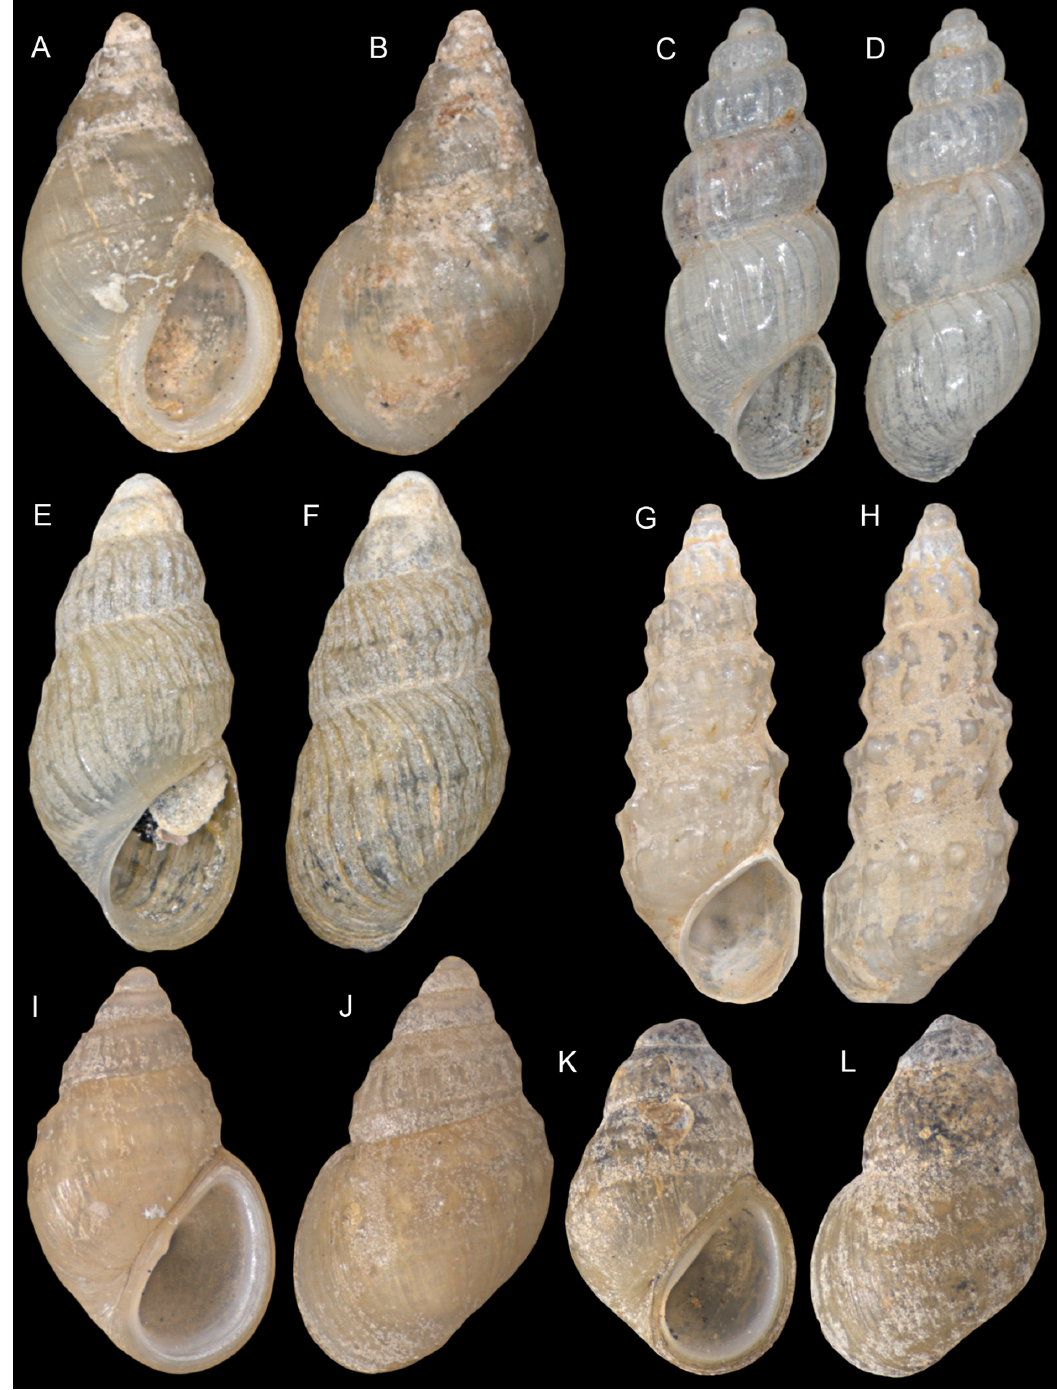
Fig. 3. A–B . Hydrorissoia cambodiensis Brandt, 1970, probable paratype MZSP 95912, L = 3.9 mm, W = 2.3 mm. C–D . Hubendickia cylindrica Brandt, 1974, probable paratype MZSP 95944, L = 4.5 mm, W = 1.8 mm. E–F . Hubendickia rolfbrandti Temcharoen, 1971, probable paratype MZSP 95948, L= 4.1 mm, W = 2 mm. G–H . Paraprososthenia schuetti Brandt, 1968, probable paratype MZSP 95487, L = 6.2 mm, W = 2.1 mm. I–J . Hydrorissoia hospitalis Brandt, 1968, probable paratype MZSP 95949, L = 3.2 mm, W = 1.9 mm. K–L . Hydrorissoia munensis Brandt, 1968, probable paratype MZSP 95929, L = 2.76 mm, W = 1.74